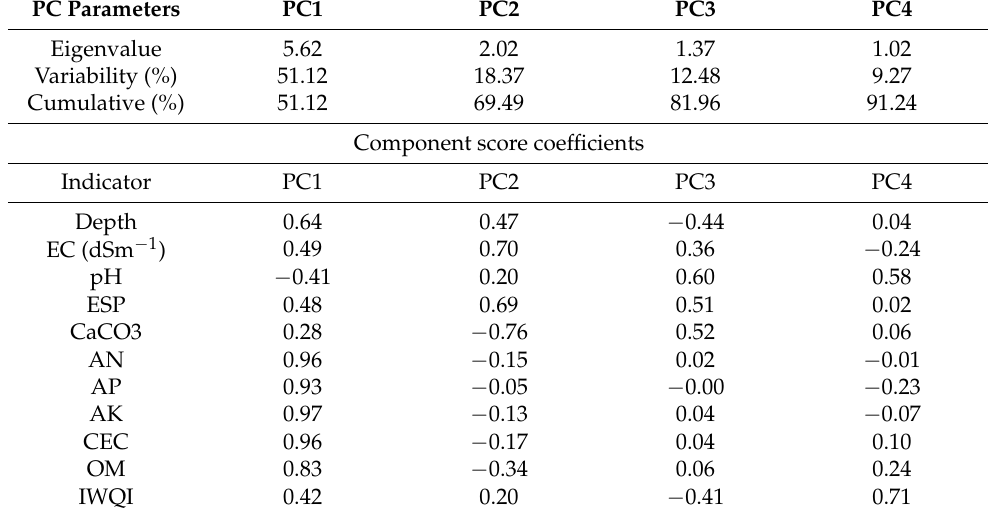
Table 1. Summary of